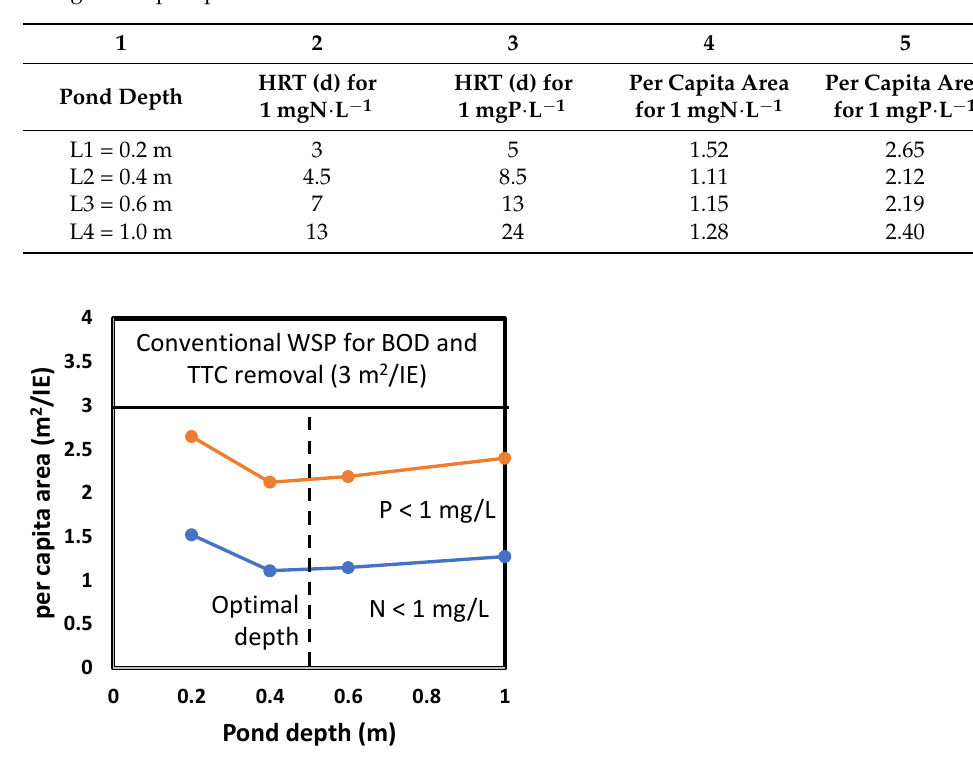
Table 3. Average values of the retention time and required area per inhabitant for <1 mg · L − 1 of nitrogen and phosphorus in the final effluent.